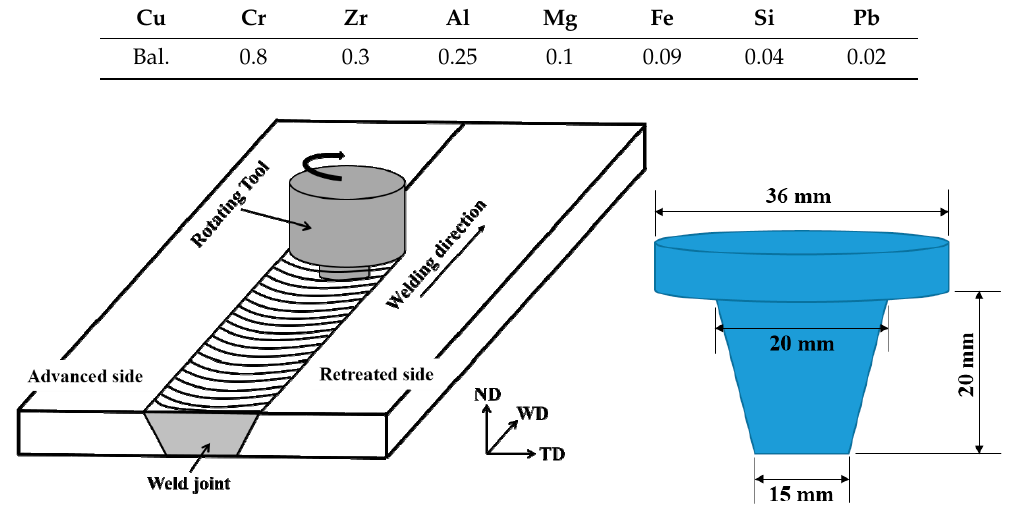
Figure 1. Schematic presentation of friction stir welding technique and the tool geometry used for this work.